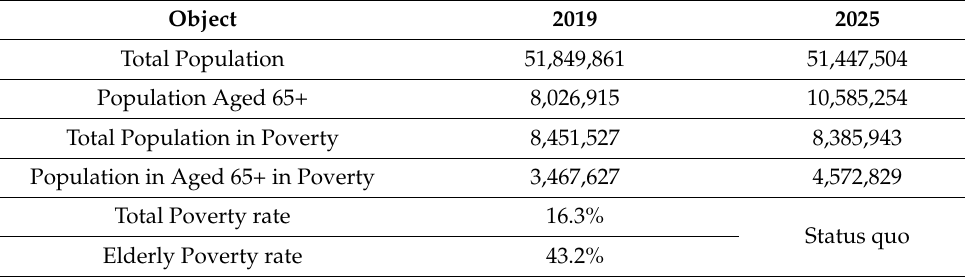
Figure 1. Poverty rates among older age groups and the total population (2016). Source: OECD [6]. Along with this prevalent risk of aging poverty, the world’s fast pace of population aging is rapidly increasing the number of elderly people in poverty (Figure 2). If the current poverty rate is maintained, the number of people aged 65 or older is expected to rise by 31.9% in 2025, from 3.5 million to 4.6 million (Table 1). Entering a super-aged society means more that 20% of the population are elderly [7]. Approximately one out of every two impoverished people will be elderly in the future. Table 1. Estimates of the total population and the elderly in poverty (2019,